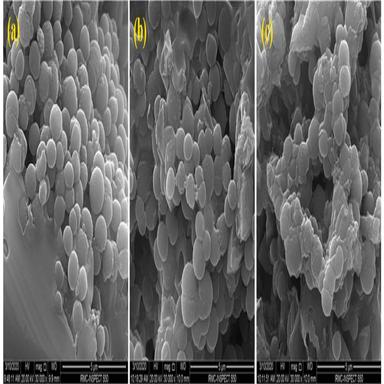
SEM images of untreated MRSA strains (a), pure g-C3N4 treated MRSA strains (b), and 10%-3C–SiC@g-C3N4 treated MRSA strains (c).